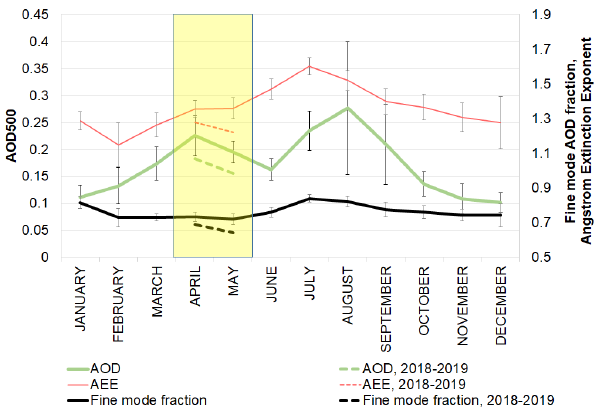
Figure 3. Seasonal changes in monthly mean AOD at 500nm, Ångström extinction exponent (AEE) at the 440–870nm interval and fine-mode AOD fraction at 500nm for the 2001–2020 period and for the April–May months in 2018 and 2019. Level 2, version 3. Moscow, MSU MO. The period of the study is shown by the yellow